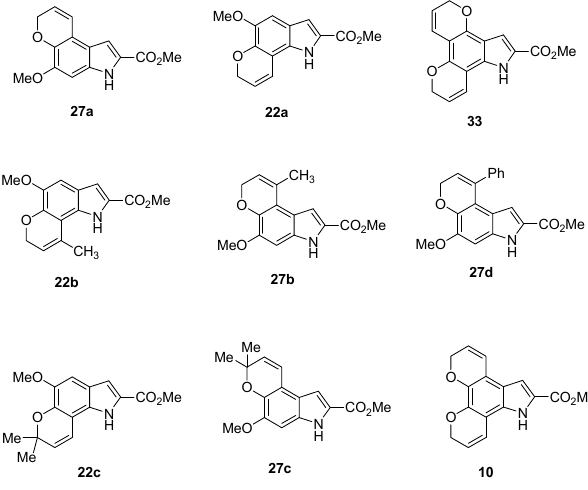
Figure 4. Synthesized and selected compounds.